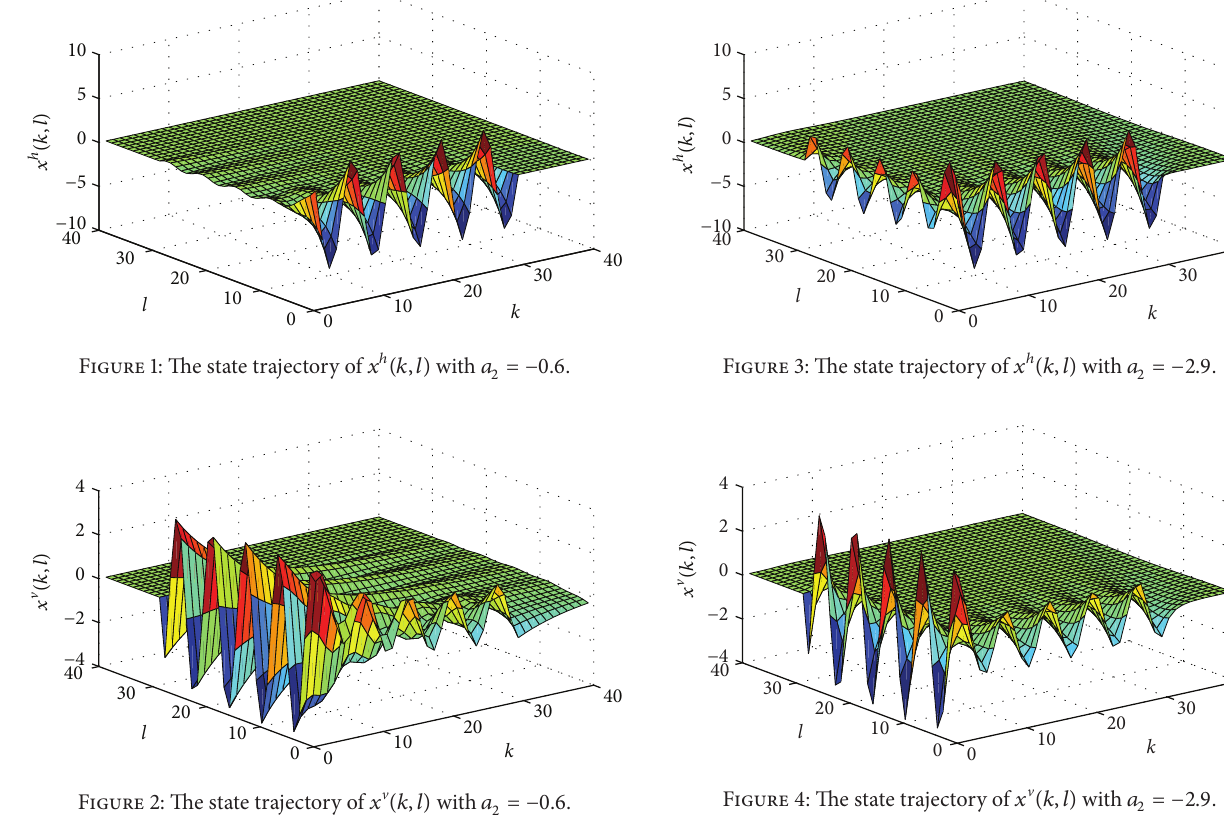
= 0.6 , respectively. 2